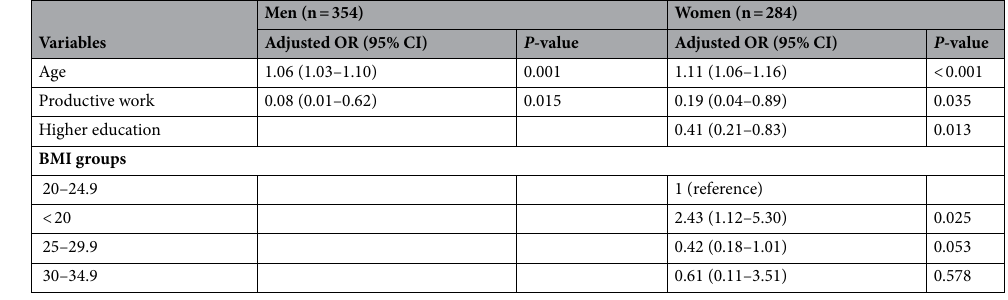
Table 5. Factors associated with frailty in the logistic regression analysis according to sex. Variables that had a P -value < 0.2 in the univariate regression were included in the multiple regression. Only variables that had a P -value < 0.05 in the multiple regression are shown. BMI body mass index, CI confidence interval, OR odds